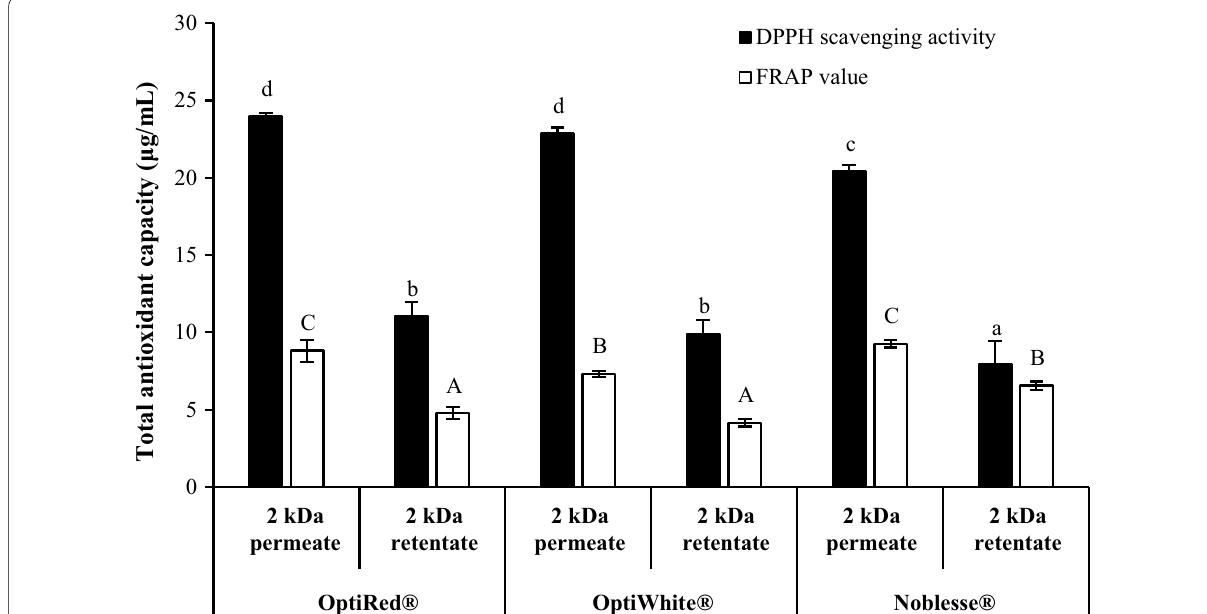
Fig. 6 Total antioxidant capacities of 2 kDa membrane permeates and retentates of IYD supernatants. Different lowercase and uppercase letters indicate significant differences ( P < 0.05) for DPPH scavenging activity and FRAP values, respectively. Values are the mean of triplicate experiments ( n 3), with error bars representing the standard deviations of the mean =